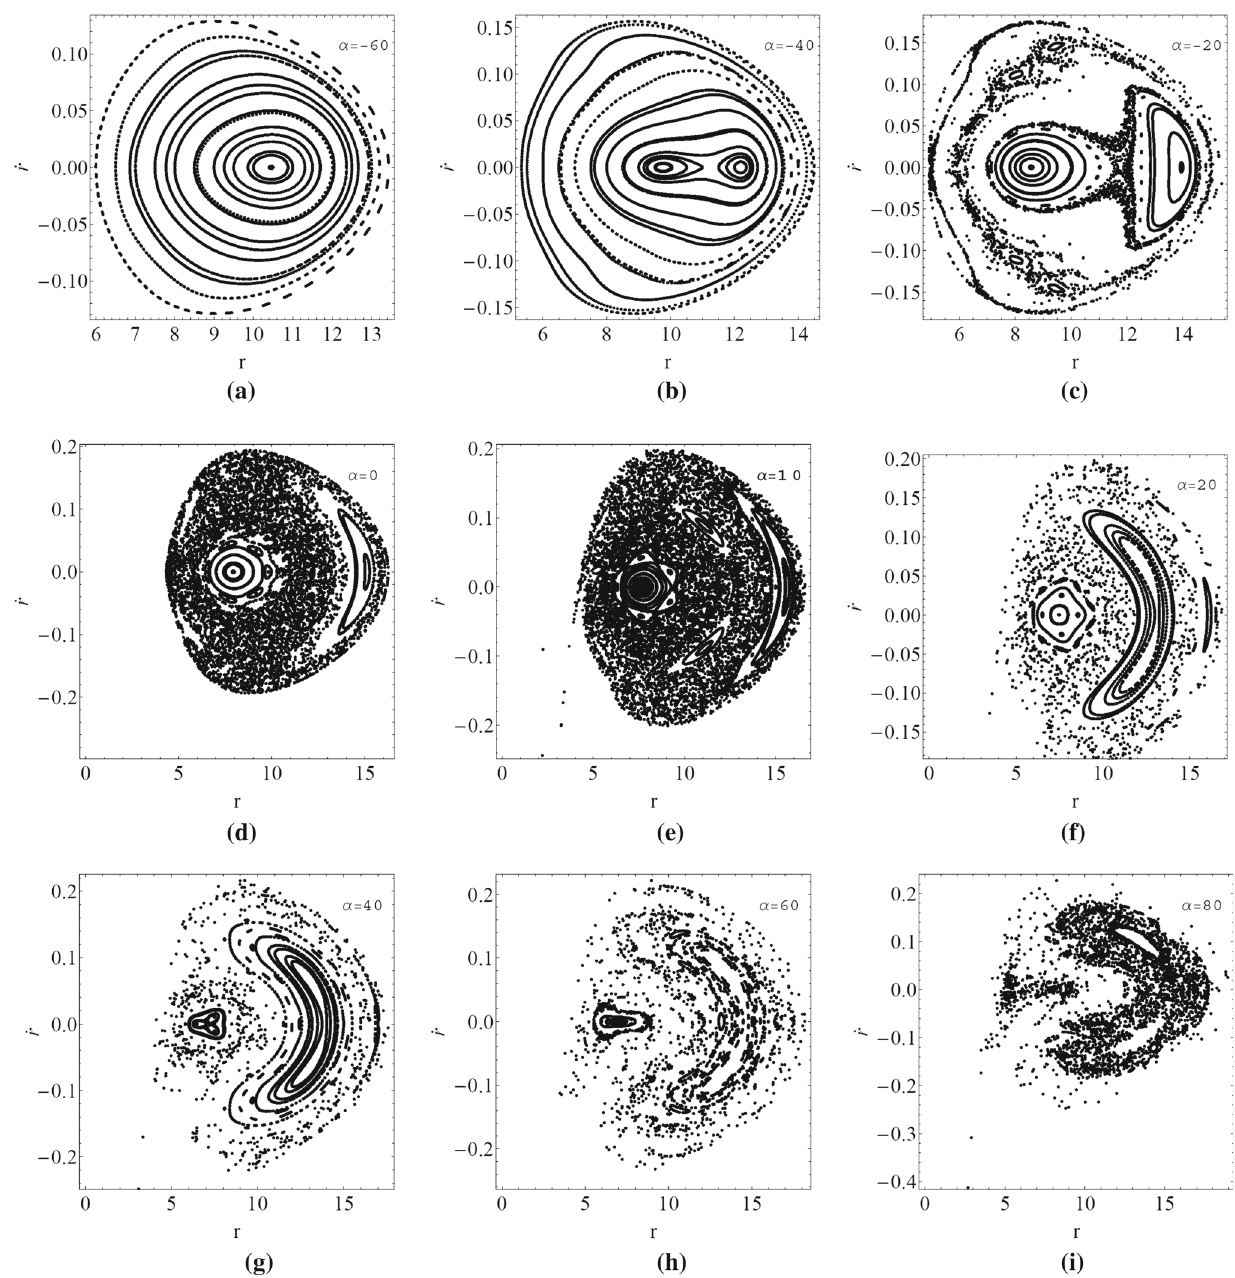
Fig. 6 The Poincaré surface of section ( θ = π